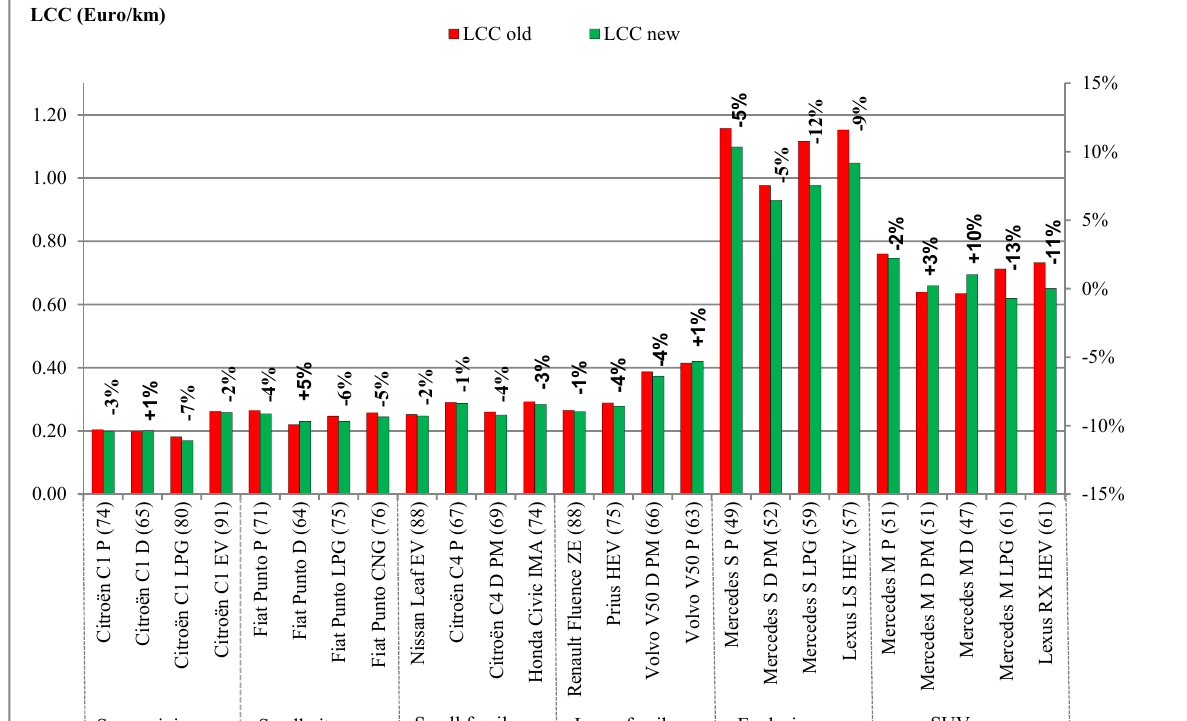
Figure 9. Life cycle cost in the Ecoscore-based vehicle taxation